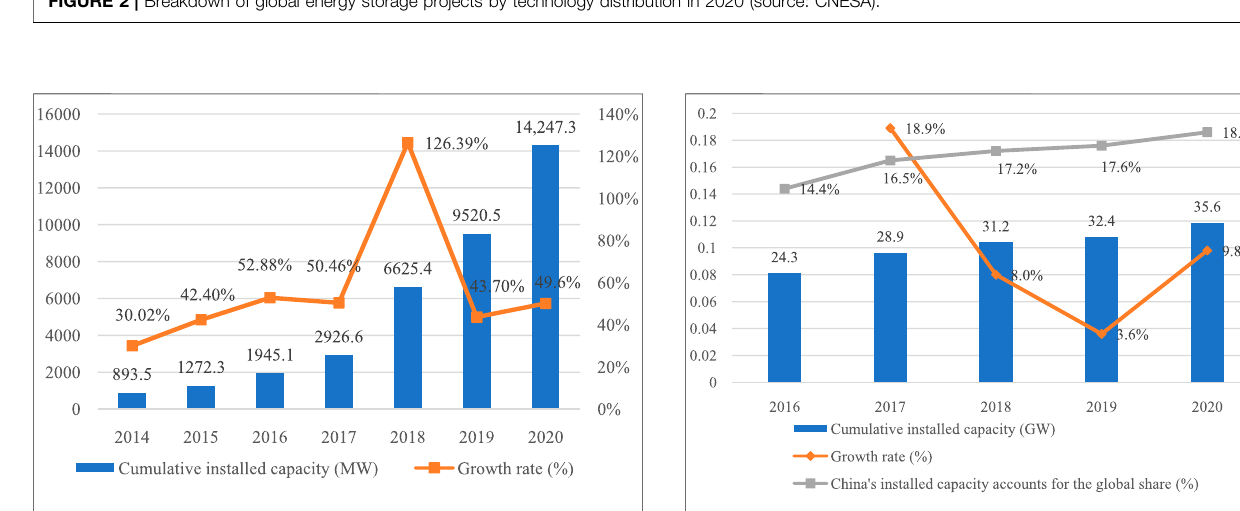
FIGURE 2 | Breakdown of global energy storage projects by technology distribution in 2020 (source: CNESA).